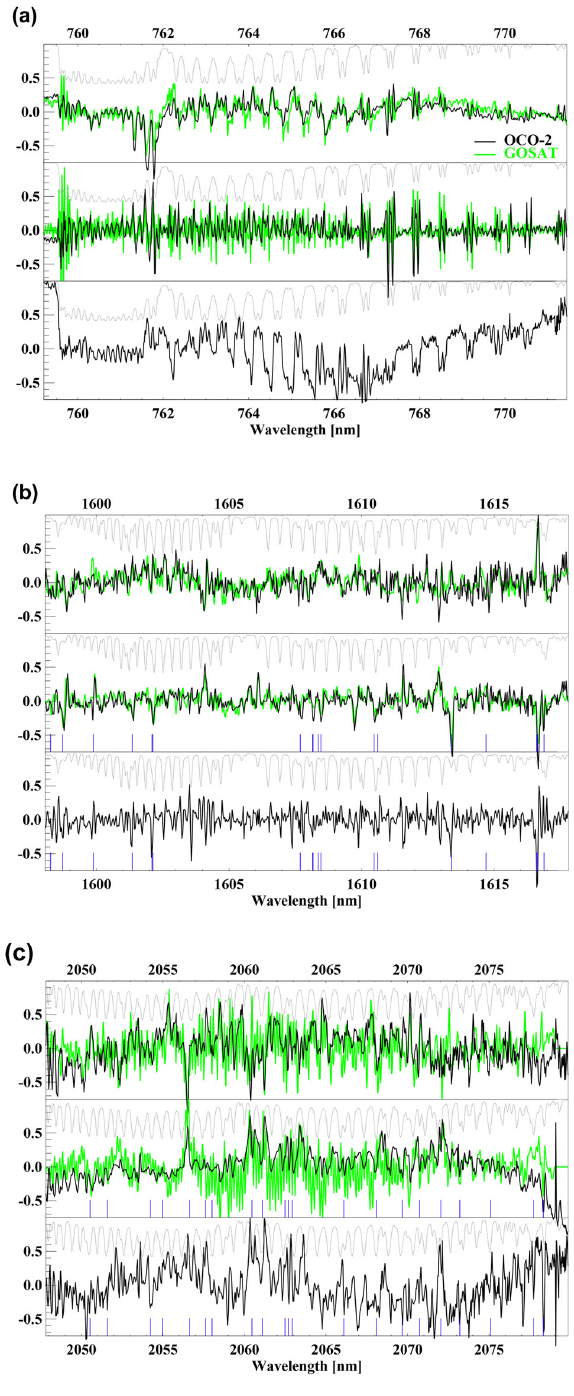
Figure 7. Spectral patterns of the EOFs for the O 2 A band (a) , weak CO 2 band (b) , and strong CO 2 band (c) , for both GOSAT B3.5 (green) and OCO-2 B7 footprint 4 (black). For reference, the light gray trace in each panel shows the modeled spectrum (not to scale). Some stronger water vapor absorption lines (blue vertical lines) in the weak and strong CO 2 bands correlate with features in the second and third